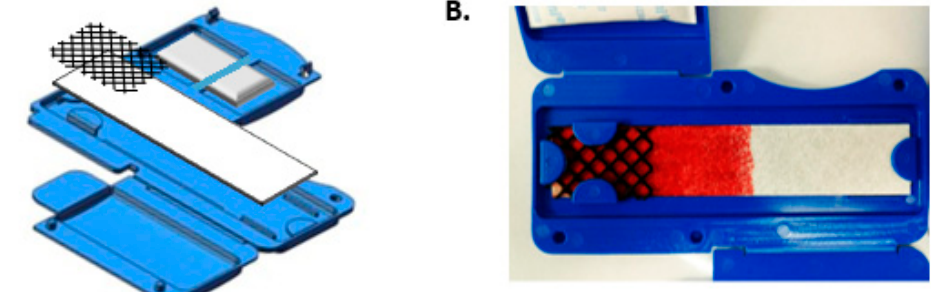
Figure 1. A. Schematic illustration of the blood-collection device. B. Representative separation membrane after application of whole blood showing separation of the red blood cells from the liquid portion of whole blood.